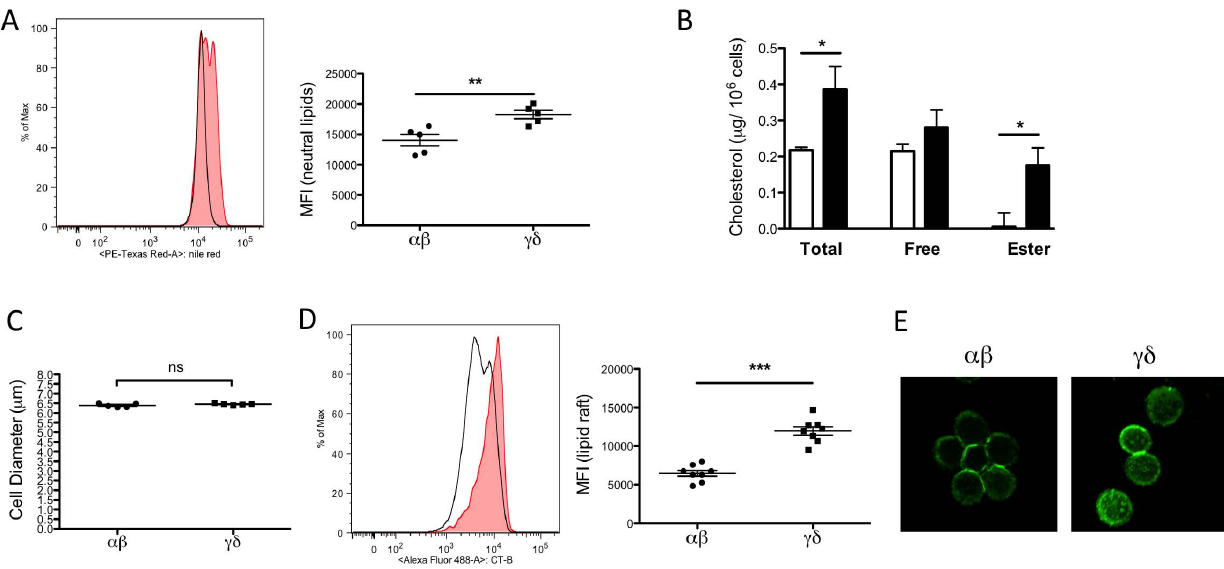
Figure 2. cd T cells have increased intracellular neutral lipids, cholesterol, and lipid rafts. (A) Splenocytes were isolated from C57BL/6J mice. Intracellular lipid was quantified by Nile Red staining. Left: A representative plot shows the relative intensity of Nile Red staining on ab (solid black line) and cd (tinted shade) T cells. Right: Graph shows the median florescent intensity of Nile Red staining on ab and cd T cells. Results were averaged from 5 mice, and shown in mean 6 SEM. (B) Total and free cholesterol was quantified in purified ab (white) and cd (black) T cells from C57BL/6J mouse spleens by gas chromatography. Cholesteryl ester was calculated as the difference between total and free cholesterol (multiplied by 1.67). Intracellular total cholesterol and cholesteryl ester content is significantly higher in cd T cells. Cholesterol level was normalized to cell numbers. N=5. (C) ab and cd T cells were isolated from splenocytes of C57BL/6J mice. Average cell diameters were obtained from a Multisizer IV Coulter Counter (Beckman Coulter) and showed no significant difference (ns) in ab and cd T cells. Results were averaged from 5 mice, and shown in mean 6 SEM. (D) Staining for GM1 shows significantly higher lipid raft content on the plasma membrane of cd T cells. Splenocytes were isolated from C57BL/ 6J mice. GM1 of lipid raft was identified by cholera toxin subunit B (CT-B) binding. Left: A representative plot shows the relative intensity of CT-B staining on ab (solid black line) and cd (tinted shade) T cells. Right: Graph shows the median florescent intensity of CT-B staining on ab and cd T cells. Results were averaged from 8 mice. Results were shown in mean 6 SEM. * P , 0.05, ** P , 0.01, *** P , 0.001. (E) Confocal microscopic images show increased lipid rafts staining on the membrane of cd T cells (300 6 ). Green: GM1.